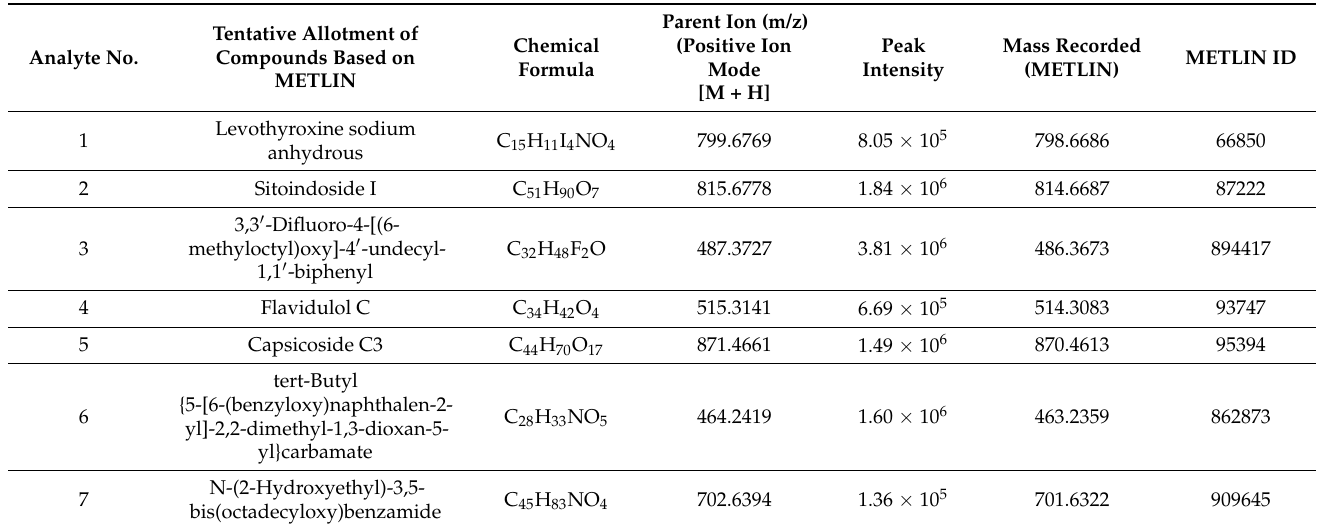
Table 1. Determination of bioactive compounds in extract of A. terreus AREF023 by LC-ESI-MS (+ion mode).